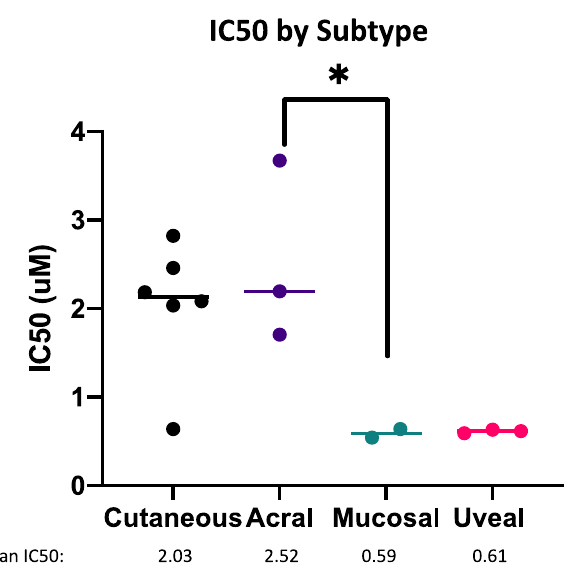
Figure 7. Mucosal and uveal melanoma are most sensitive to MCL1i + AZA. Dot plot of IC50 values for the combination of S63845 + AZA, separated by melanoma subtype. Each dot represents one cell line. * represents p < 0.05.